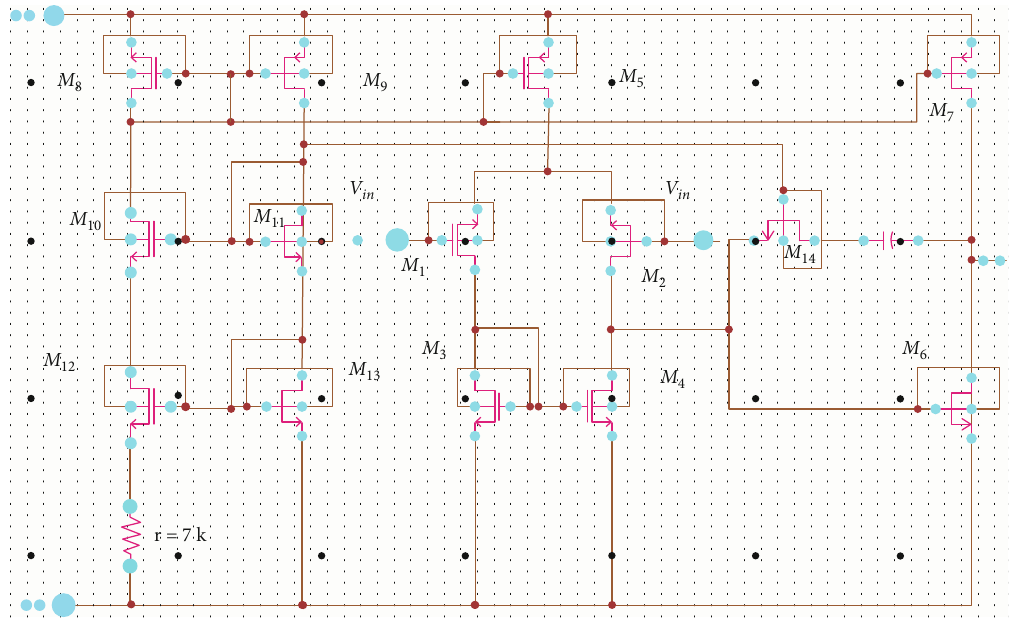
Figure 6: Two-stage di ff erential ampli fi er block